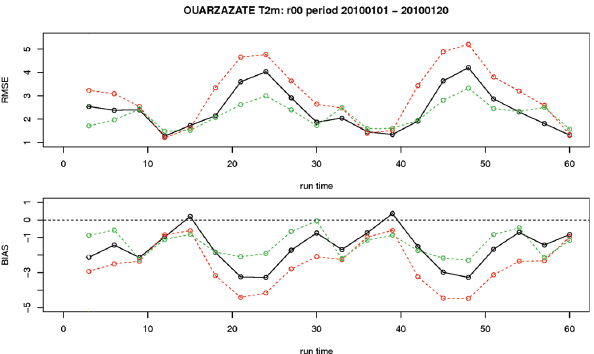
Fig. 4. Statistical scores (rmse: top; bias: bottom) of 2m temper- ature against observations at the Ouarzazat station for a winter pe- riod 1–20 January 2010 for ALADIN without SURFEX (black solid line), ALADIN with SURFEX (red dashed line) and ALADIN with SURFEX and CANOPY (green dashed lines).